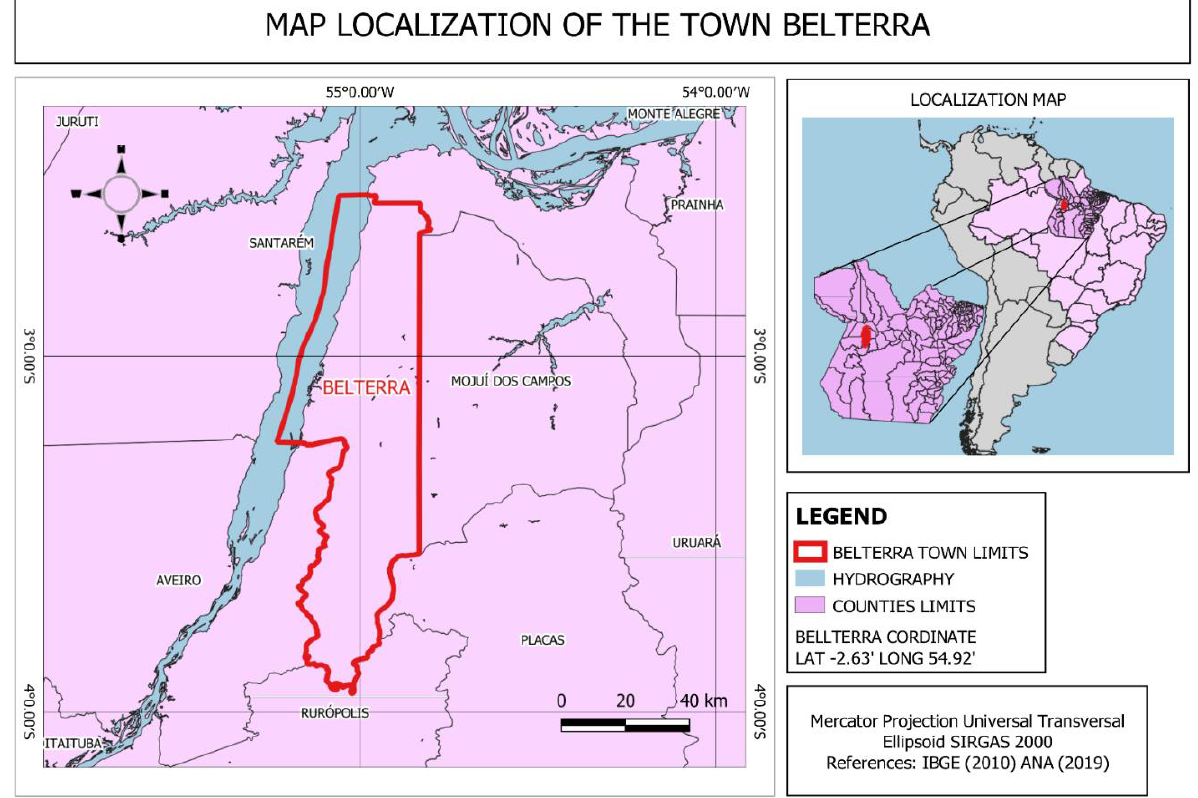
Figure 6. The geographical location of the town Belterra in the state of Par á ,